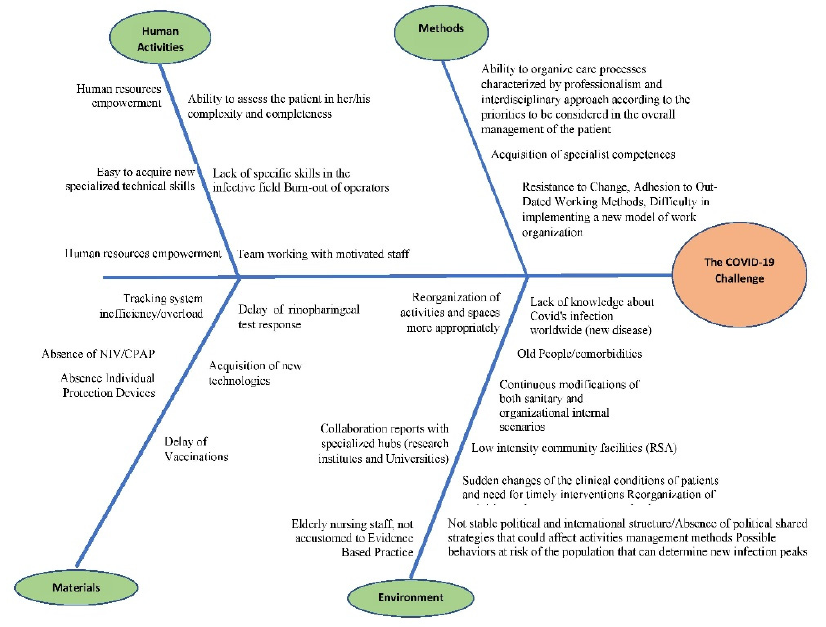
Figure 2. Ishikawa diagram.